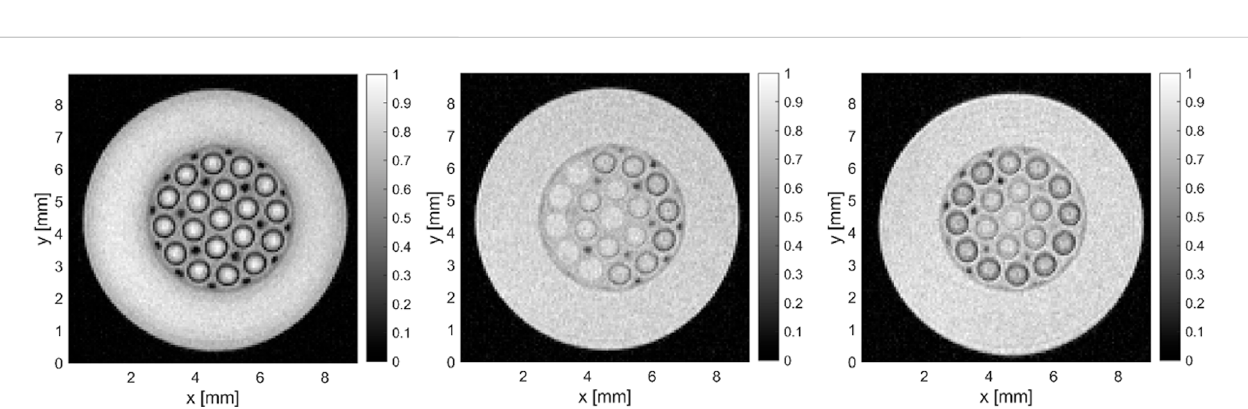
FIGURE 6 From left to right:After fi ltration, dark deposit ringsare visible inall 19 channels ( z = 32.5 cm). At z = 32.5 cm, fl ow-through reduced the deposit in seven channels nearly completely, in additional fi ve channels to a large extent, while the deposit is still prominent in seven channels located in the outer ring. At z = 27.7 cminstead, fl ow-throughreducedthedepositintheinnerchannels.Pleasenotealsothebehaviorofthedark,air- fi lledregions:Whiletheyappeardarkin the MR image directly after fi ltration, the less dense regions appear at least partially fi lled with water in the images during fl